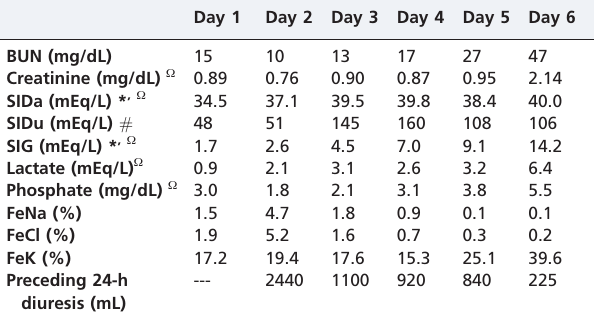
Table 1 - Traditional renal and physicochemical parameters in the evolution of